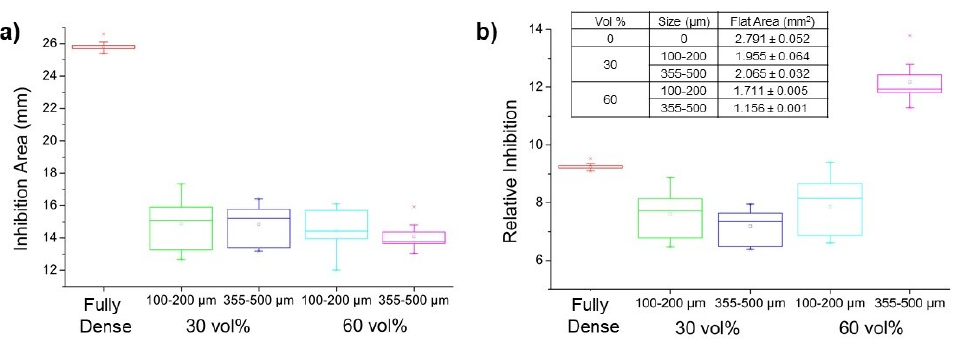
Figure 7. Antibacterial behavior showed by AgNPs-coated Ti substrates, considering ( a ) the total inhibition area obtained for each substrate and ( b ) the relative inhibition related to the flat area of each type of sample (flat surface calculated from a total titanium discs surface of 2.835 mm 2 , considering an ideal fully dense substrate without micropores). These results are consistent with the total inhibition area observed in a sample with 40% porosity recently reported by our group [56]. This inhibition area is located between the inhibition area obtained for samples with 30 and 60 vol.% porosity. In comparison, previously reported results by Jingchao et al. [51], concerning the evaluation of inhibition halos of fully dense Ti coated with AgNPs showed negligible zones of inhibition due to a low concentration of silver ions in the surrounding environment.